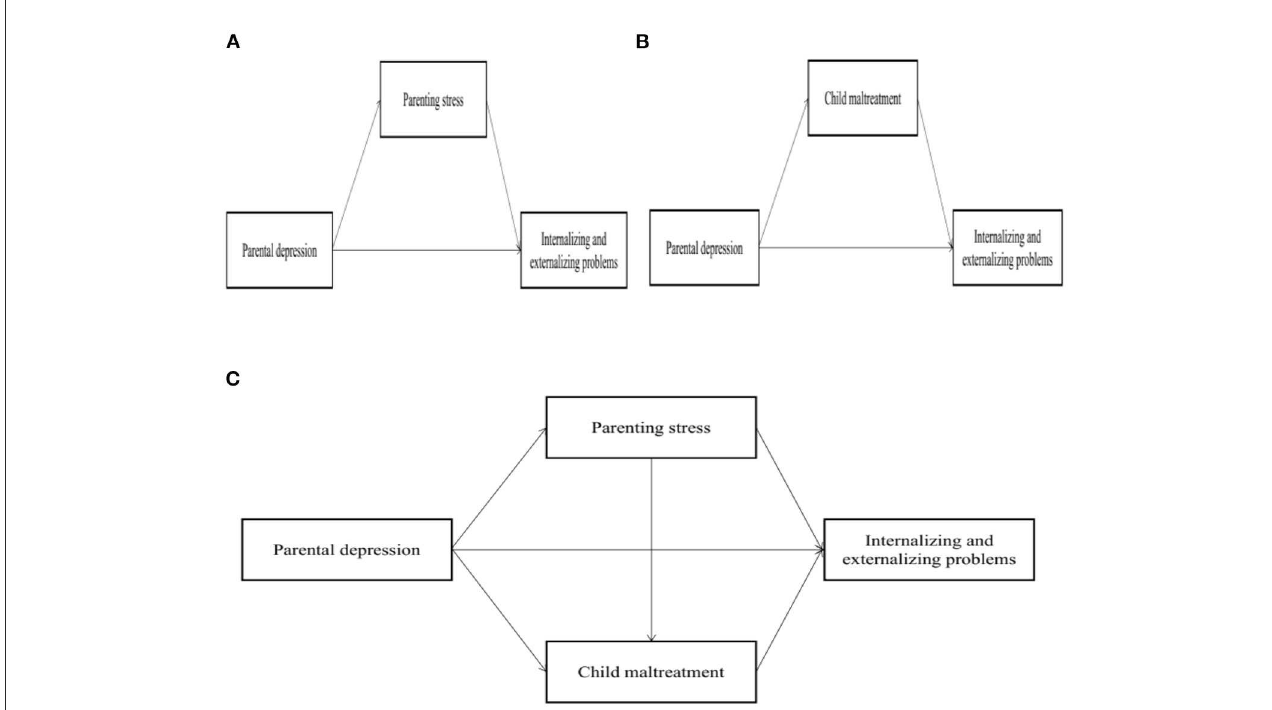
FIGURE1 Hypotheses models. (A) model: Parenting stress model; (B) model: Child maltreatment model; (C) model: The combination of parenting stress and child maltreatment model.